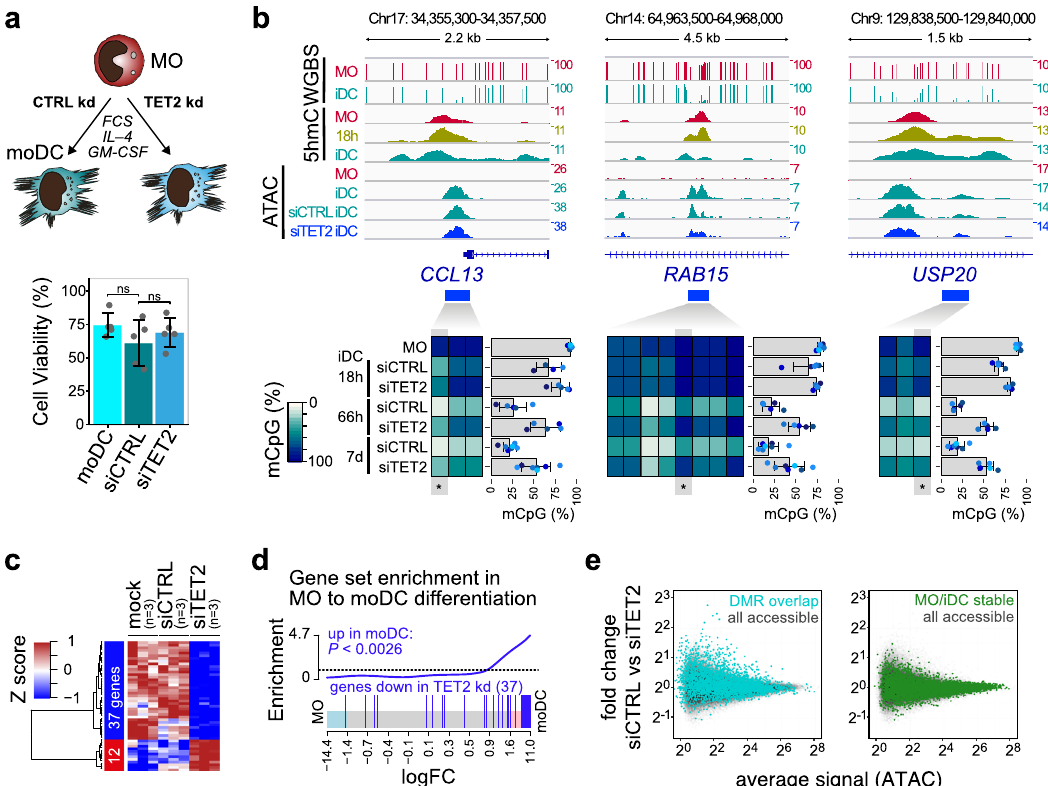
Fig. 2 Impact of TET2 knock-down (kd) on cell viability, gene expression, chromatin accessibility, and DNA methylation. a Schematic of the experimental setup and effect of siTET2 treatment on moDC viability relative to the number of cultured monocytes. Bars in the bottom panel represent mean ± SD of n = 5 biologically independent experiments. Shown are values for untransfected moDC as well as siRNA-transfected cells (siCTRL, siTET2). Individual data points are shown as gray dots (ns, not signi fi cant, paired t -test, two-sided). b IGV genome browser tracks for the indicated WGBS, 5hmC, and ATAC data sets at regions around example DMR that were previously identi fi ed in moDC 10 . Corresponding DNA methylation ratios for the indicated regions are given below. For heatmaps, methylation ratios (representing means of n = 5 (18 h and 66 h) or n = 7 (MO and 7 d) biologically independent experiments) are indicated by coloring (white: no methylation, dark blue: 100% methylation, gray: not detected) with each column representing a single CpG. For each region the data of a single CpG (highlighted and marked by asterisks) is shown. Bars represent mean ± SD, individual data points are shown as colored dots (each color representing a different donor). c Heatmap presenting scaled expression data of differentially expressed genes (FDR ≤ 0.1, RPKM ≥ 1) between control- (siCTRL) and siTET2-treated cells. d Barcode plot demonstrating the enrichment of the set of genes downregulated in siTET2- treated cells in moDC (compared to MO). The enrichment P -value of the two-sided rotation gene set test is indicated. e MvA plots for ATAC-seq data comparing control (siCTRL) and siTET2 treatment. Coloring indicates ATAC peaks overlapping DMR (top panel) or ATAC peaks that remain stable (invariant) during MO differentiation. ( a – e ) Source data are provided as a Source Data fi